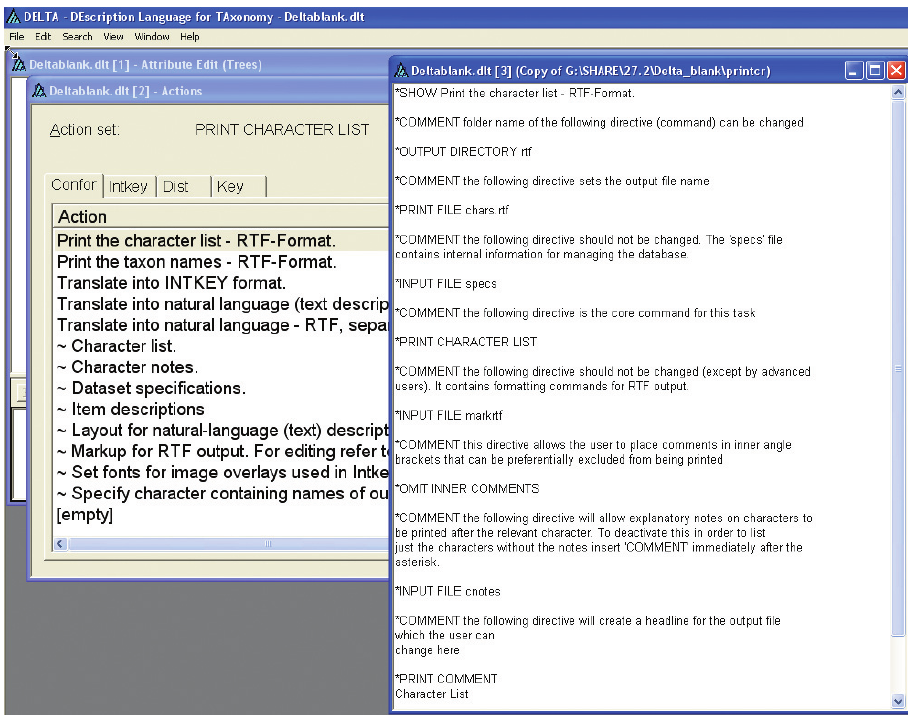
Figure 23. Th e Print the character list ( printcr ) directive fi le was opened by pushing the Edit